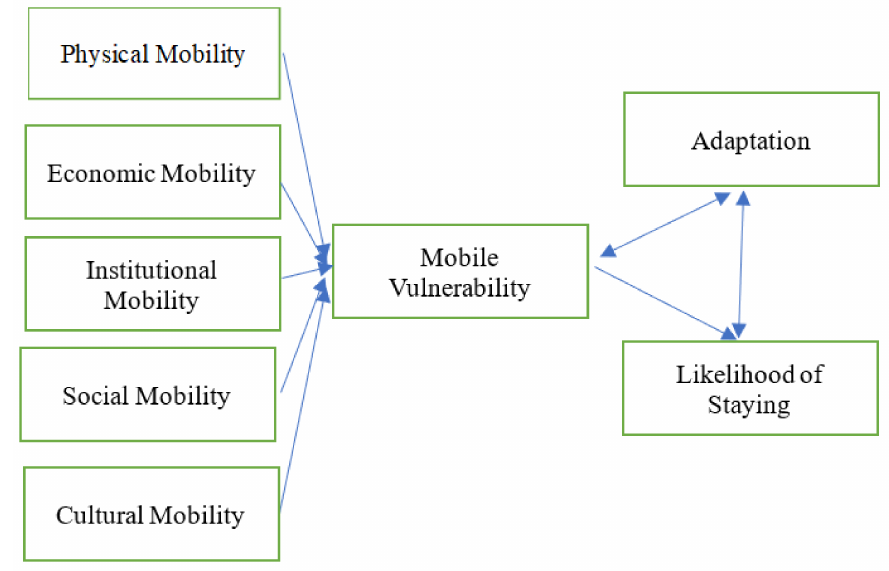
Figure 1. The conceptual framework of mobile